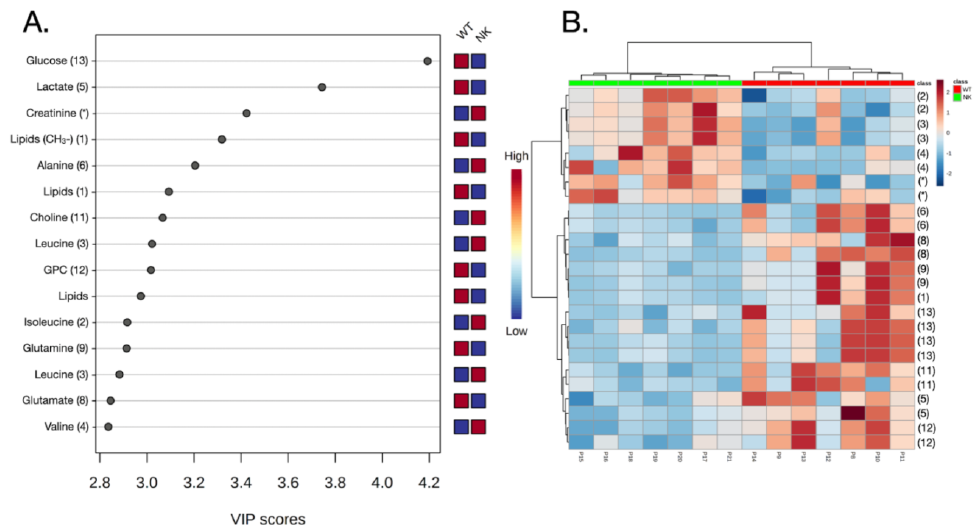
Figure 4. ( A ) Variable Importance in Projection (VIP) scores greater than 2.7 obtained in the 1 H-NMR CMPG HRMAS model by PLS-DA. The most significant concentration variations were observed for lipids, lactate, and glucose, as could be seen for the model when the seven WT and seven NK paired samples were analyzed. The numbers given in brackets correspond to the metabolites’ assignments shown in Figure 1. ( B ) Cluster analysis presented as a heatmap. The WT samples are shown in red, and the numbers in brackets correspond to the metabolites’ assignments shown in Figure